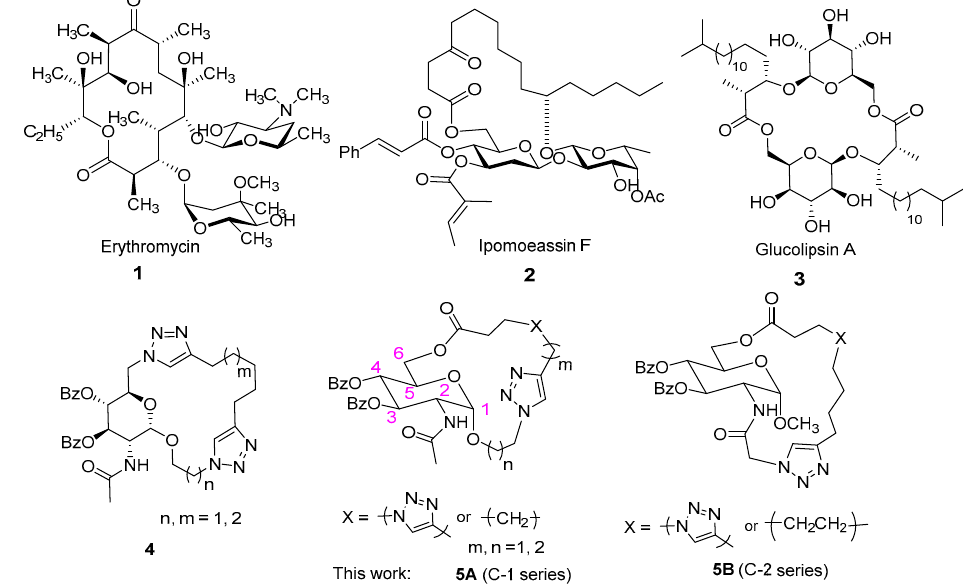
Figure 1. Structures of several carbohydrate-based